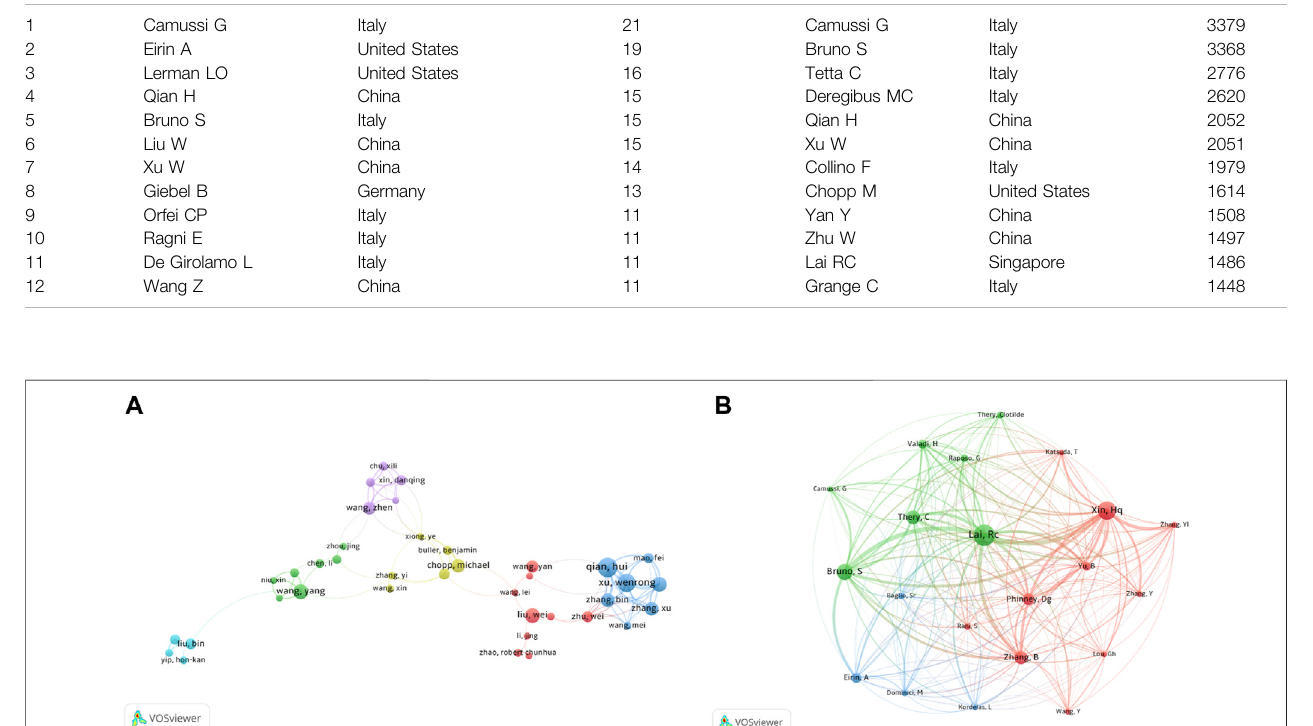
We detected the burst of keywords based on CiteSpace ’ s algorithm of burst detection, where the minimum duration of the burst was set to 2 years. The discontinuous blue lines represent the timeline, speci fi cally, each small blue rectangle represents 1 year, and